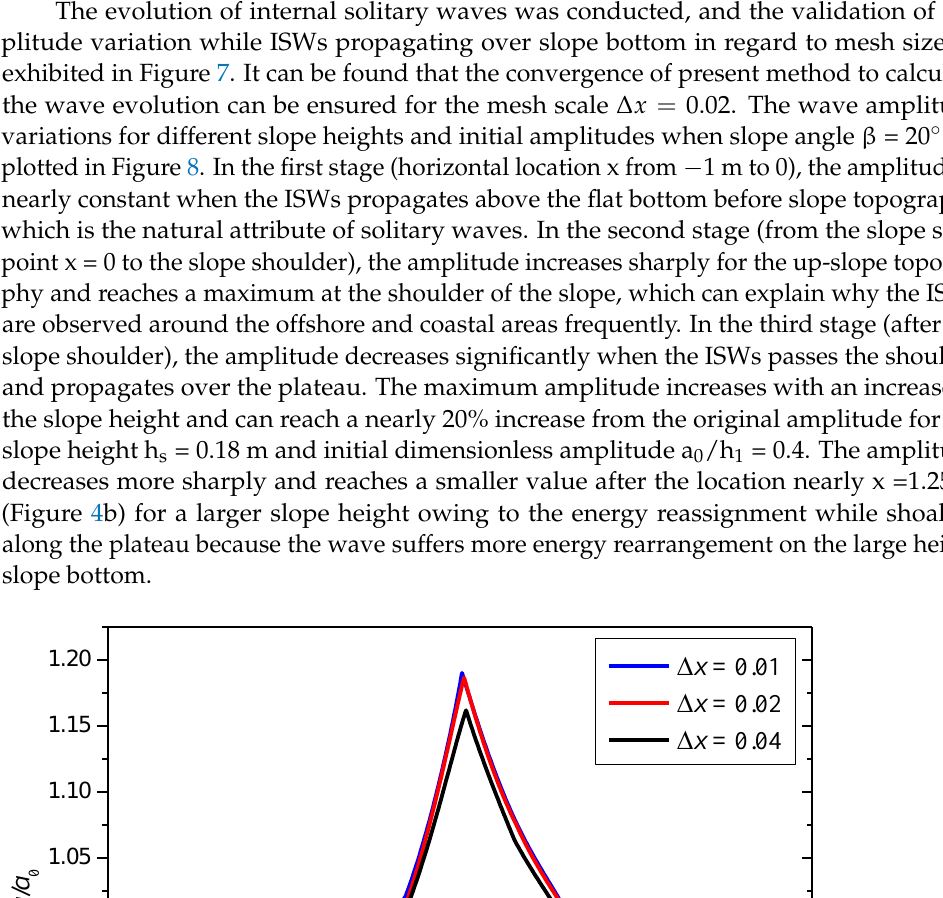
( b ) Figure 8. Variation in dimensionless amplitude for different initial amplitudes and slope height along the propagation direction. The cases for the initial dimensionless amplitudes a 0 /h 1 = 0.2 ( a ) and 0.4 ( b ), angle β = 20°, respectively . The wave amplitude variations at different initial amplitudes are shown in Figure 9. It can be seen from the figure that the dimensionless maximum amplitude with respect to a 0 increases with an increase in the initial amplitude, and a more notable decrease can be